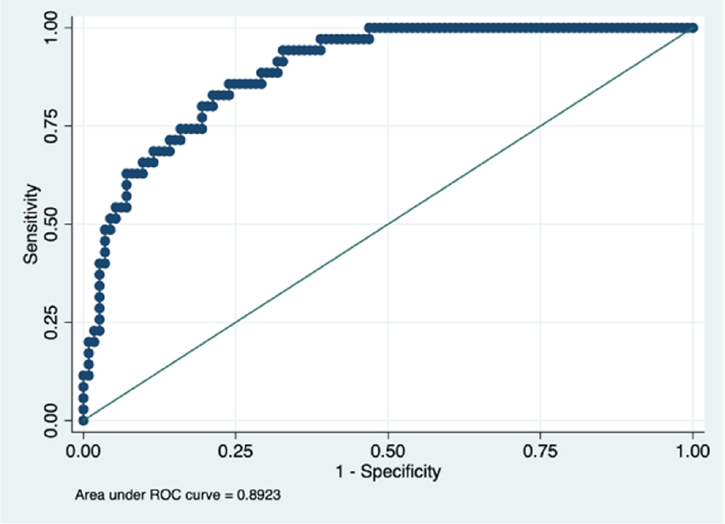
Figure 3. Predictive capacity for the cut-off point >40 points for the PDQ-39 questionnaire at one year. Figure legend. AUROC to determine the predictive ability of the model in the validation cohort, representing the sensitivity on the y-axis and specificity on the x-axis.